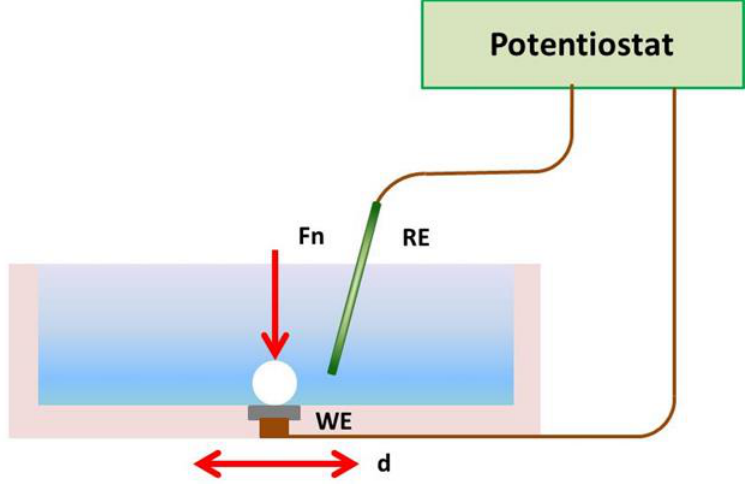
Figure 1. Schematic representation of reciprocating ball-on-plate tribocorrosion experimental setup: Fn — normal load, d — alternative displacement; WE — working electrode (tested sample); RE — reference electrode (saturated calomel electrode).